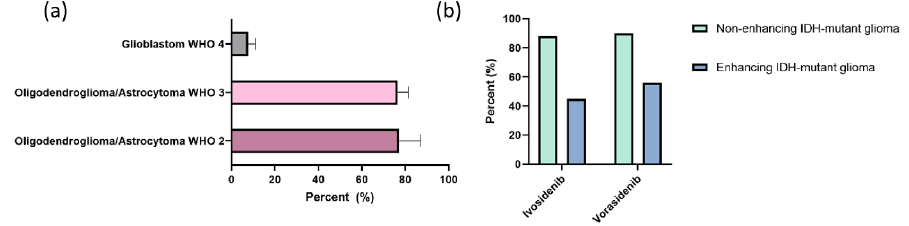
Figure 2. ( a ) Prevalence of Isocitrate Dehydrogenase (IDH) mutation in gliomas; ( b ) disease control